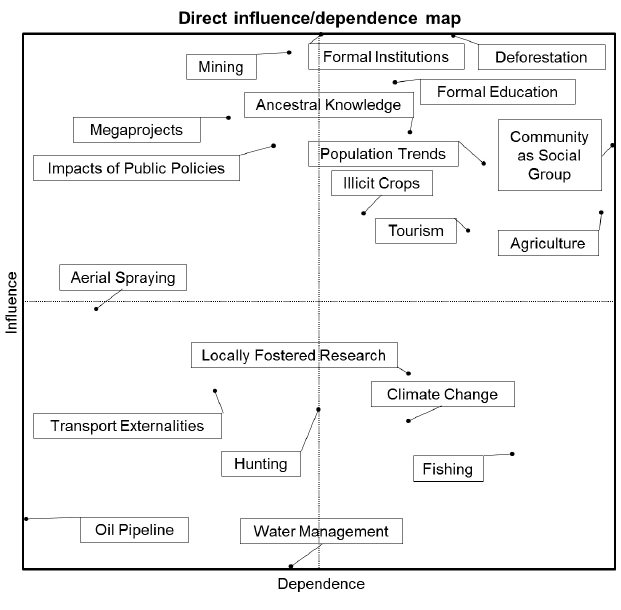
Fig. 5 . Influence/dependence map for direct influences in